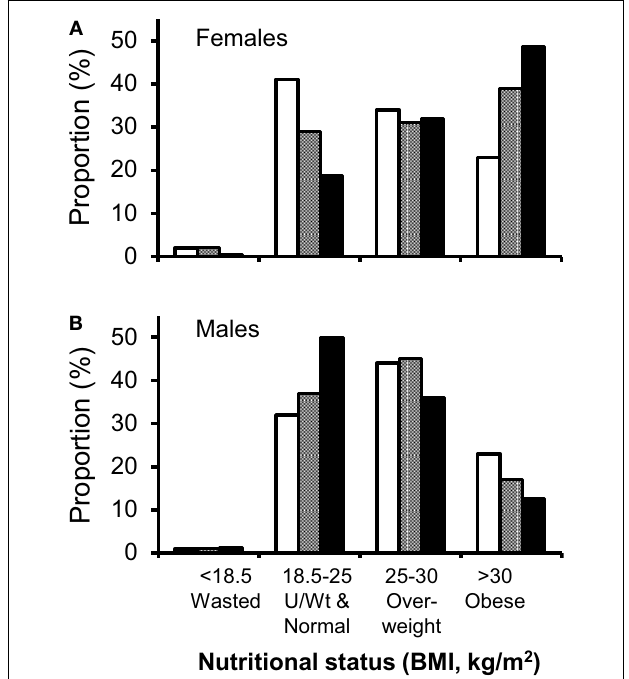
FIGURE 4 | Comparison of nutritional demographics in HIV-clinic attenders to the general population . Distribution between different nutritional status groups for HIV-positive clinic attenders (solid bars) versus the general population (open and hatched bars). (A) Men, general population (open), black African men in general population (shaded), HIV-positive Caucasian males (solid bars), and (B) women, general population (open bars), black African women in general population (shaded), HIV-positive black African women (solid bars). Comparative data (HSE), expressed as percentage of each ethnic group, are from the Health Survey of England ( n = 11,022; 5,443 classified by ethnic group, including 629 black Africans) (38). Note, HSE data did not give subgroup data for white Caucasian populations and were not subdivided at 20kg/m 2 , so “underweight” and “normal” weight clinic attenders have been conflated to demonstrate comparable data.